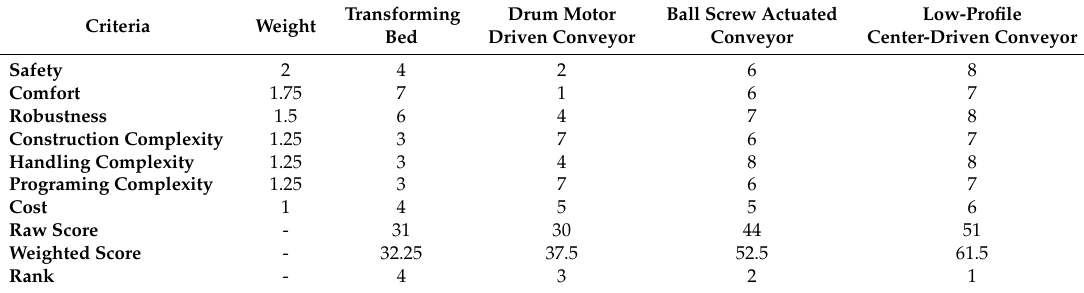
Table 1. Decision